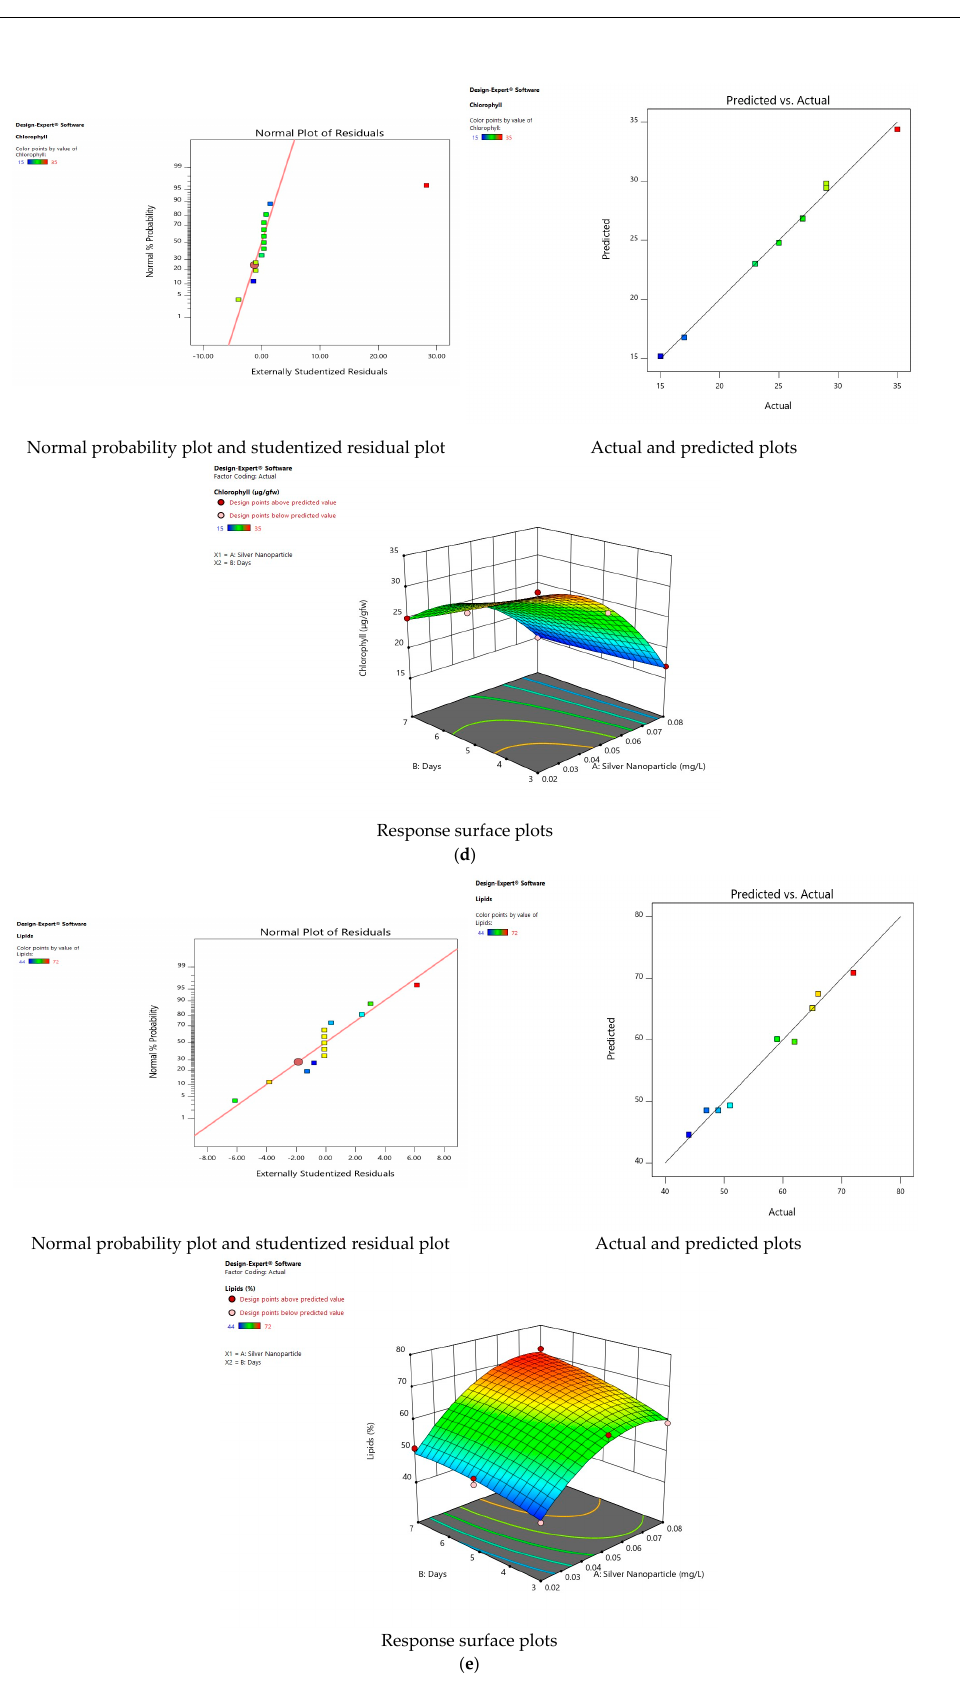
Figure 4. Response surface plots of ( a ) growth, ( b ) carbohydrates, ( c ) proteins, ( d ) chlorophyll and ( e ) lipids in Spirogyra sp. Color based on response value, as blue color shows the minimum points and red color shows the maximum points, pink color indicates points below predicted value.